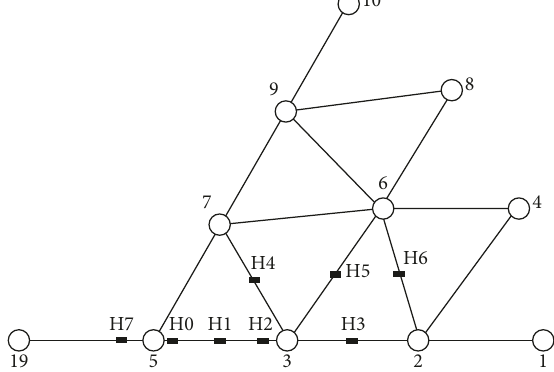
Figure 5: Gauge locations on the scale model of reticulated